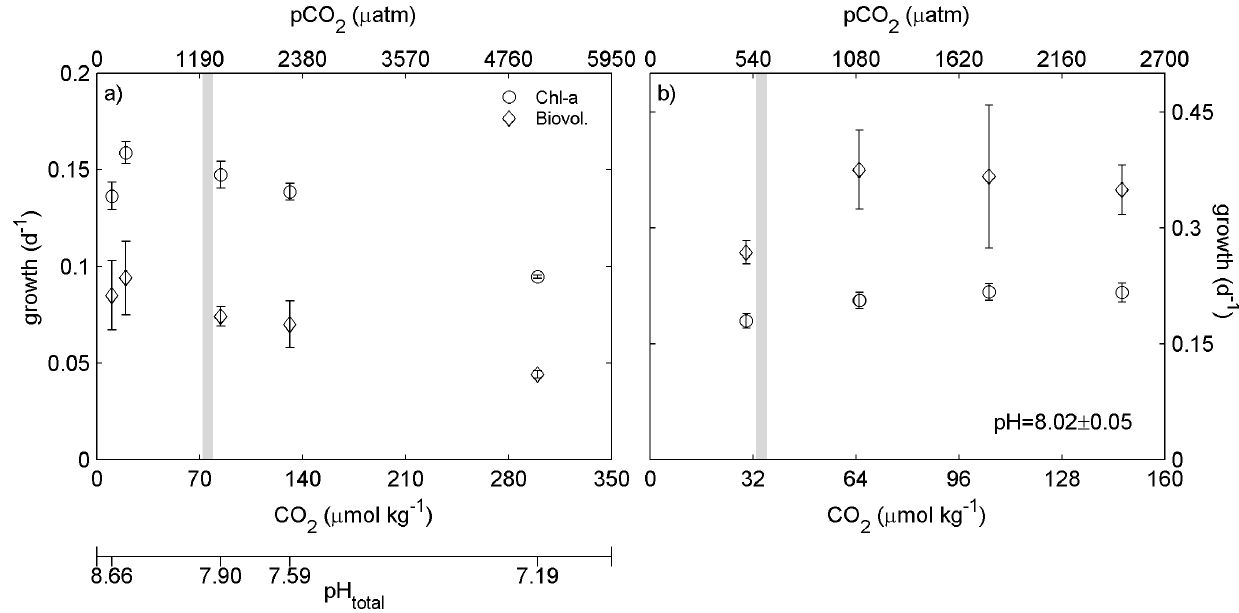
Figure 1. Growth rate changes in sea ice brine algae based on chl- a and biovolume. a: Growth rate of the brine algal incubations with varying pH, based on changes in chl- a and biovolume, in November 2012, experiment 1. b: Growth rate of the brine algal incubations (chlorophyll a and biovolume) with constant pH and varying CO 2 in November 2012, experiment 2. Vertical grey line signifies initial pH and pCO 2 . doi:10.1371/journal.pone.0086984.g001 PLOS ONE |